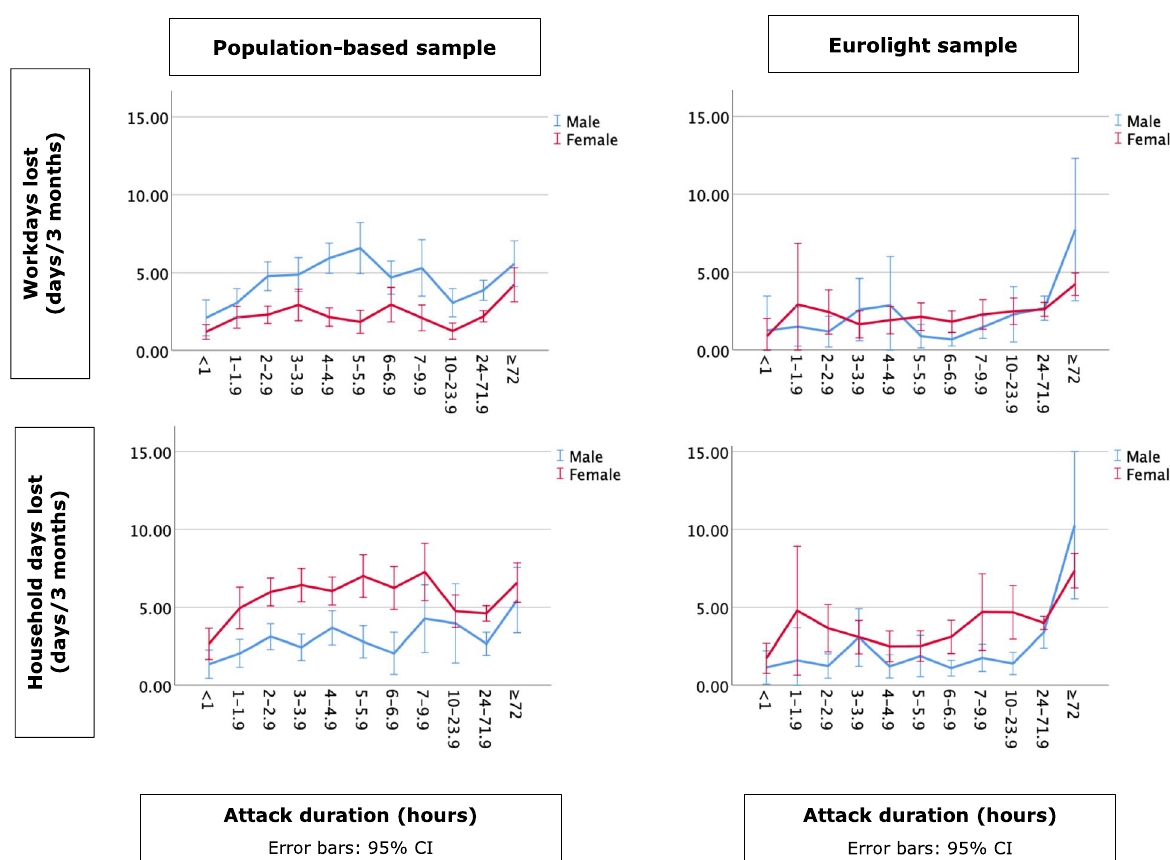
Fig. 2 Relationship between lost productivity (work days and household days) and attack duration by sample and gender. The Y axis is on the same scale as in Fig. 1 for ease of